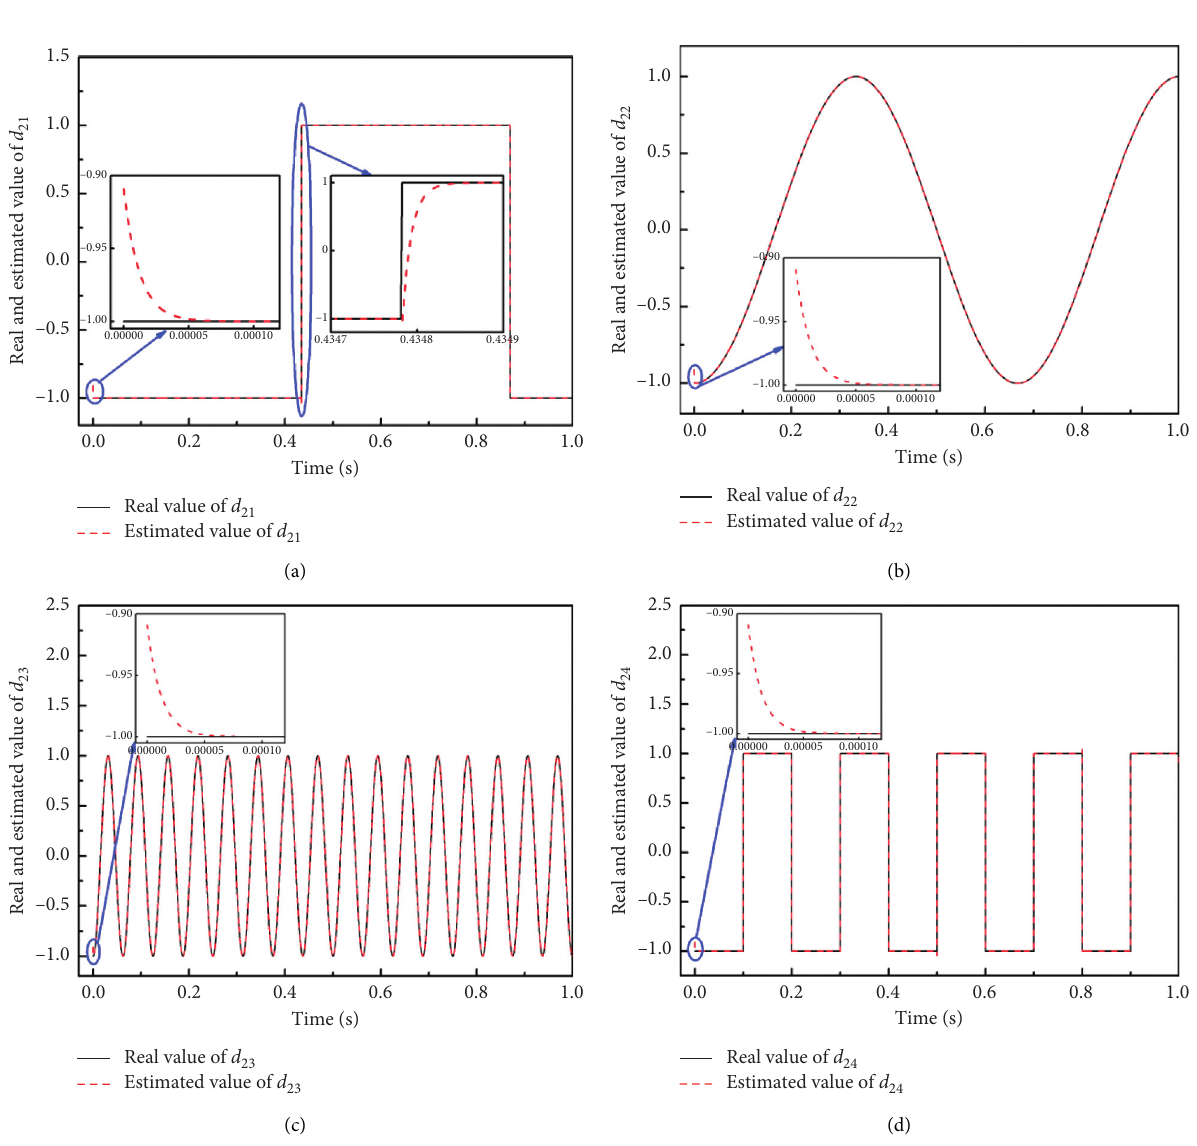
Figure 3: SMDO performance assessment curves: (a) fast-varying disturbance of Motor 1, (b) slow-varying disturbance of Motor 2, (c) high-frequency noise of Motor 3, (d) uniform noise of Motor